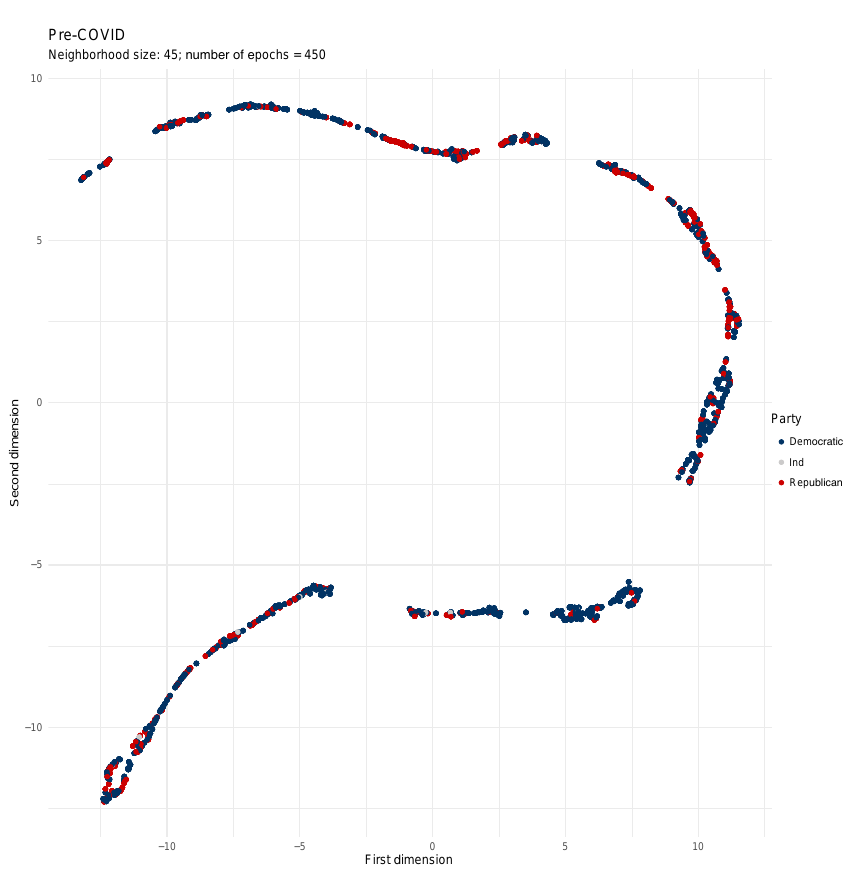
Fig. 3 Pre-COVID policymaking